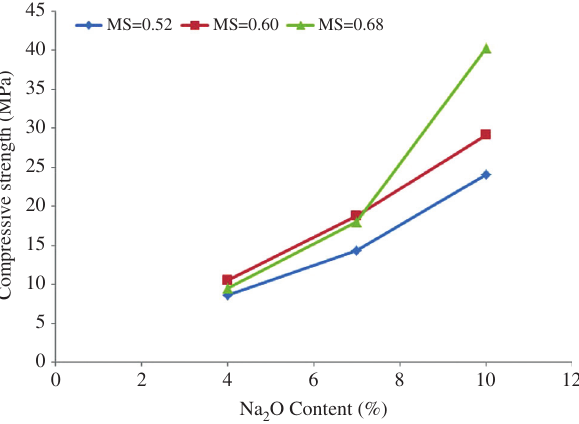
Figure 8 The effect of heat treatment temperature on 28-day com- pressive strength.